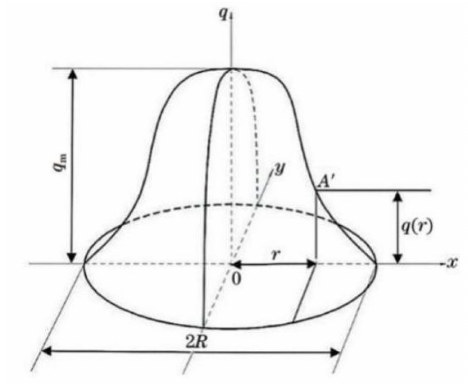
Figure 5. A Gaussian heat source model.